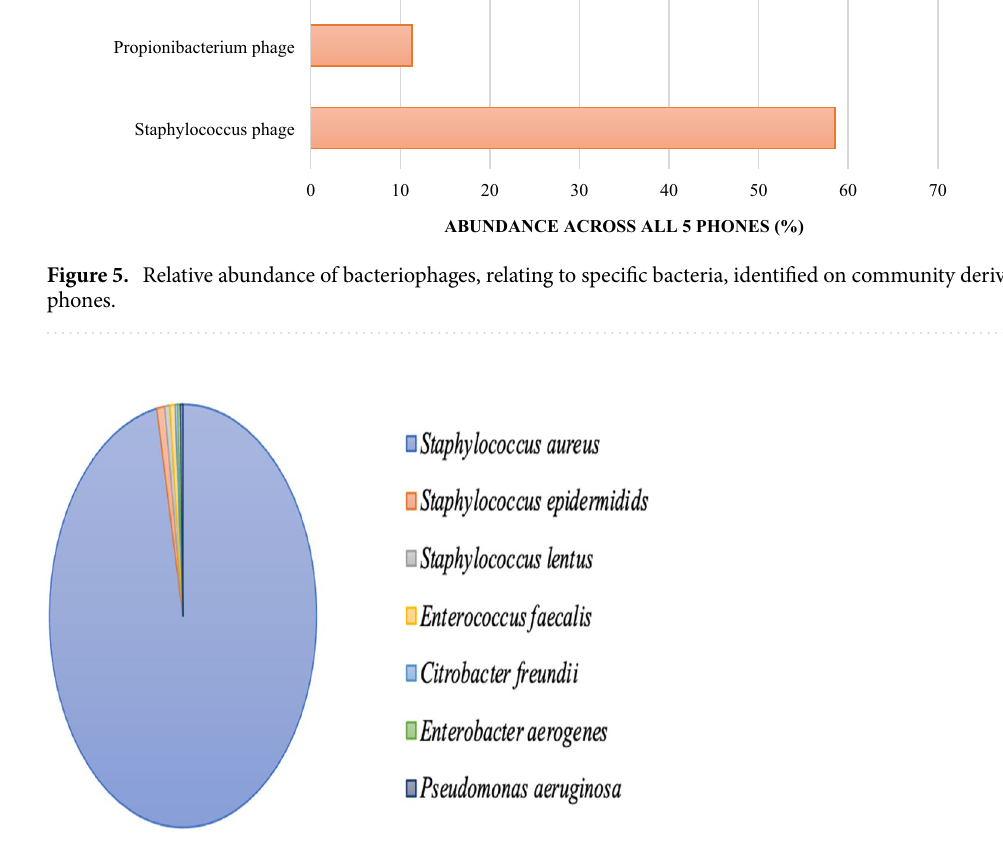
Figure 6. Relative abundance of virulence factor genes identified on community derived